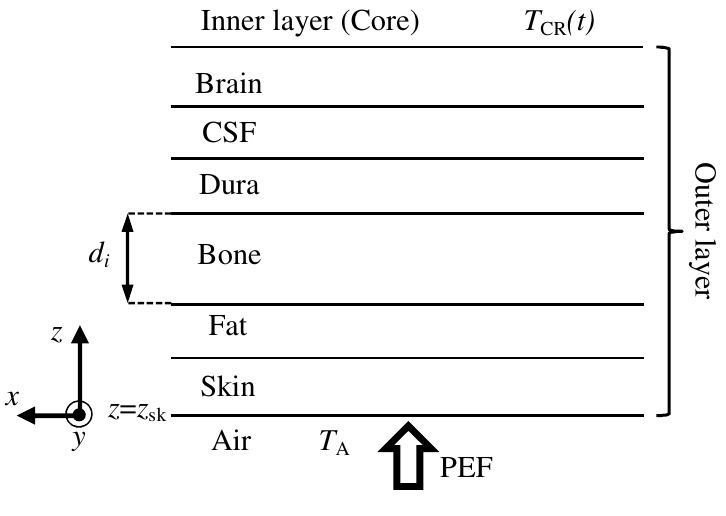
Figure 1. Sketch of the layered structure considered in the